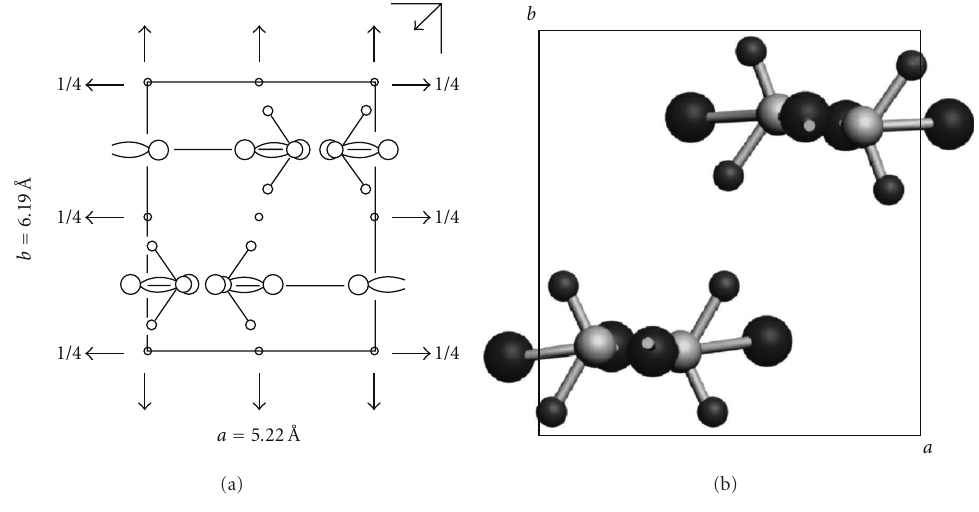
Figure 3: Crystal structure of poly(glycolic